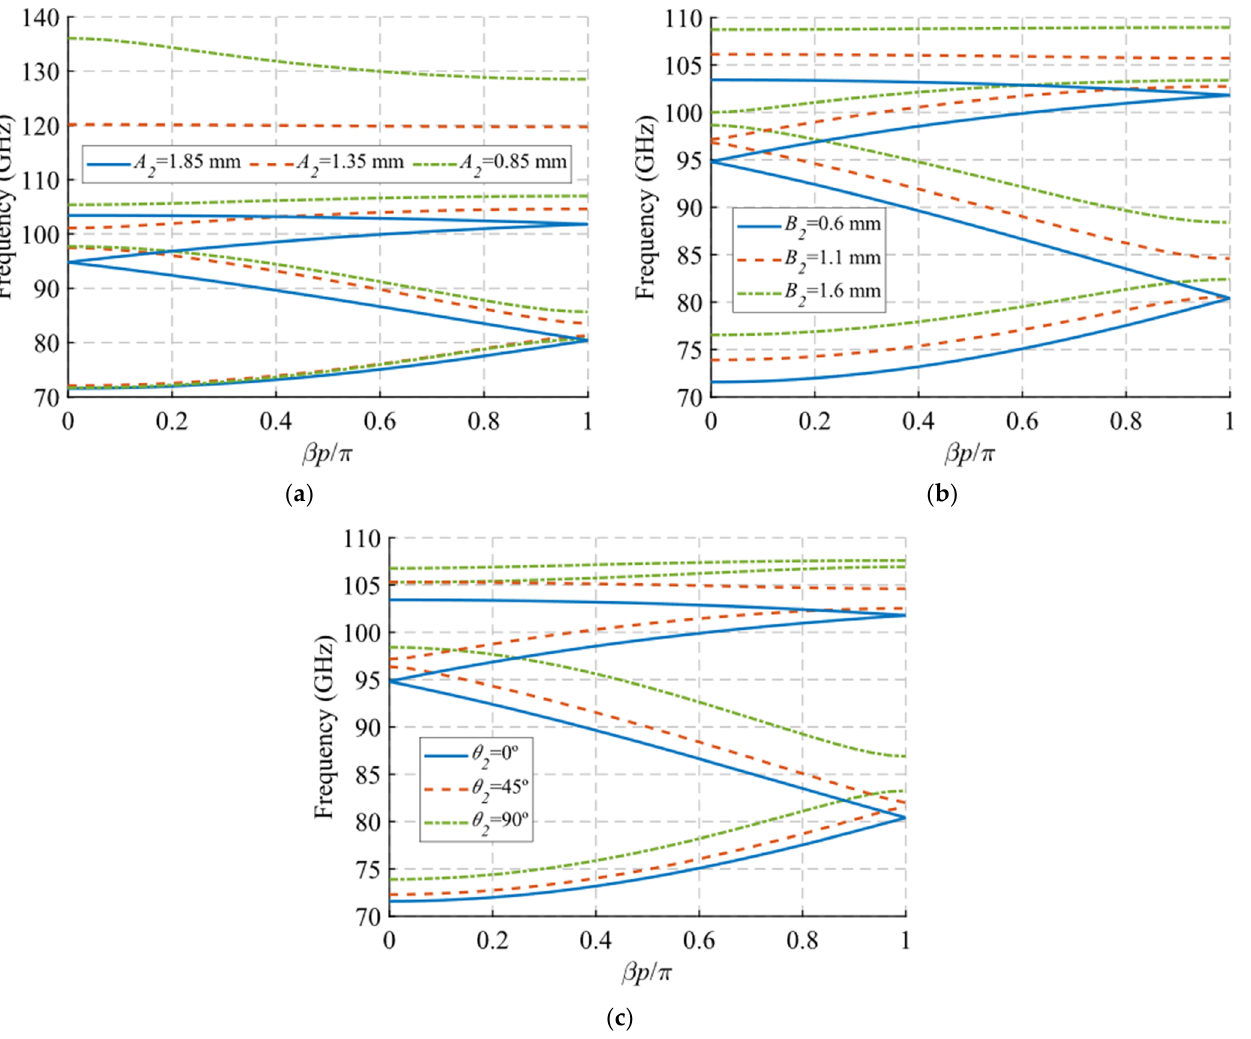
Figure 15. Dispersion diagram of the unit cell for various values of A 2 , B 2 and θ 2 when d = p /4. Transformation from double-periodic to single-unit cells for various values of ( a ) A 2 , ( b ) B 2 and ( c ) θ 2 .